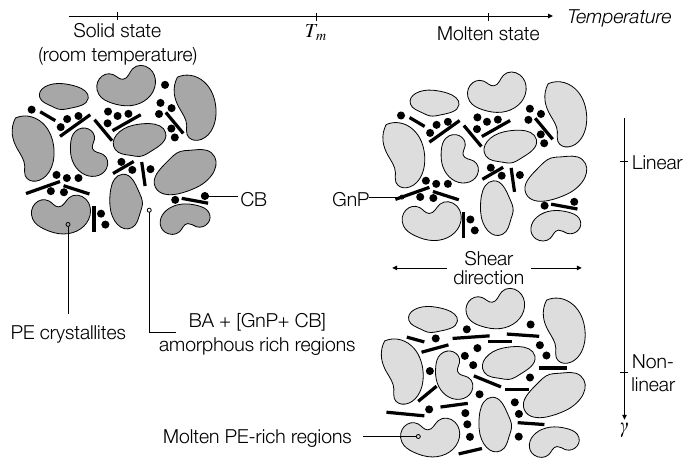
Figure 11. Interpretation of the dynamic behavior of the hybrid nanocomposites studied in the nonlinear viscoelastic regime, based on the model of Leblanc and Jäger [13].